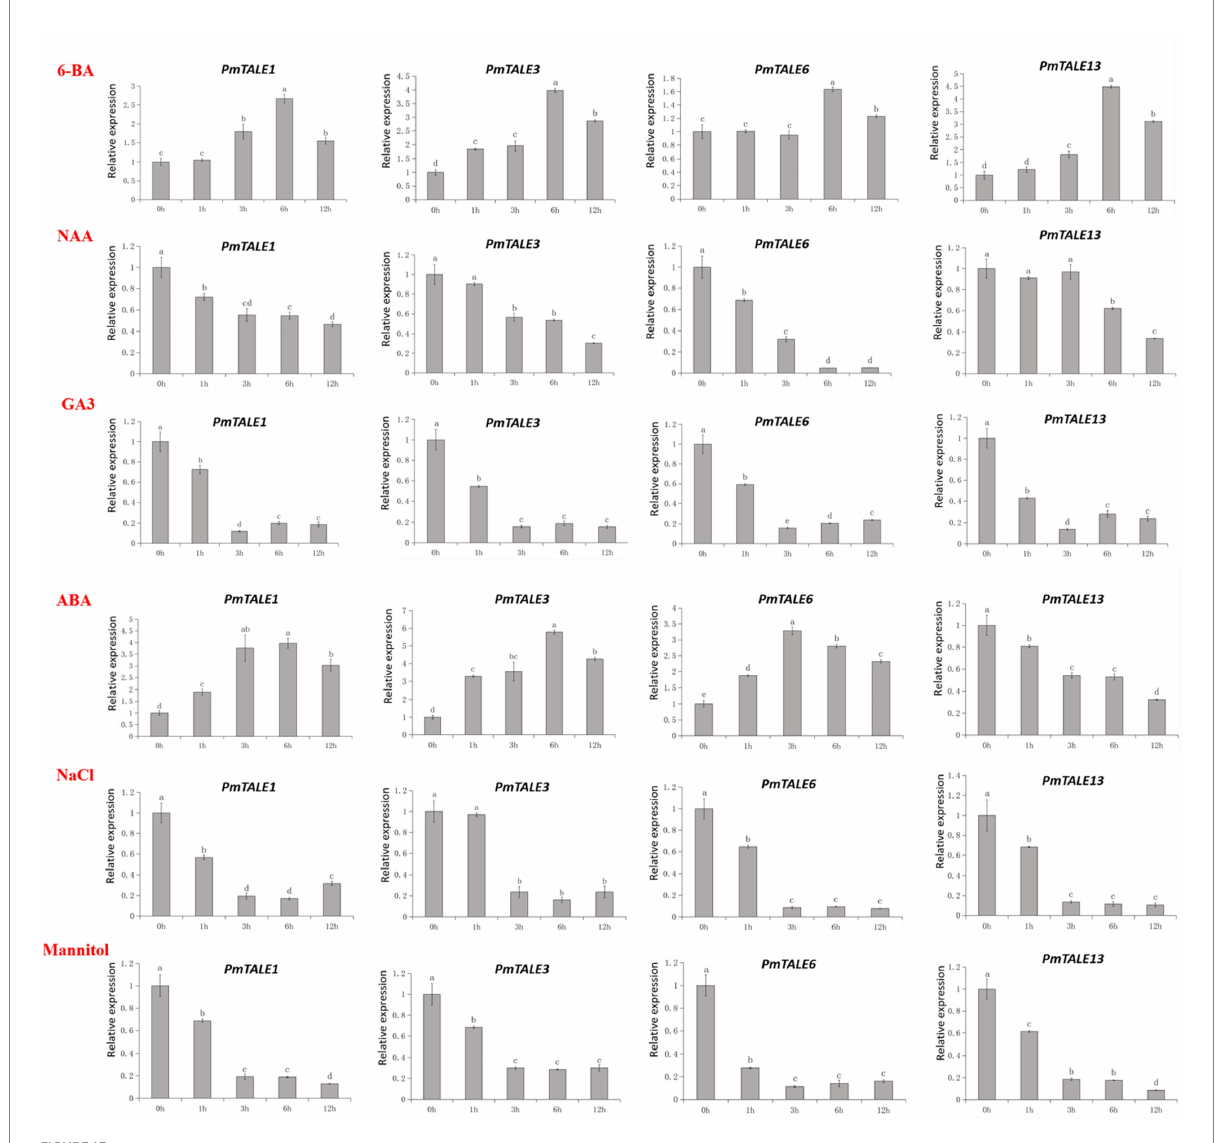
FIGURE 13 Expression profiling of Prunus mume TALE genes under different hormone treatments and different abiotic stress conditions. The abscissa represents the treatment time of hormone or abiotic stress, and the ordinate represents the relative expression